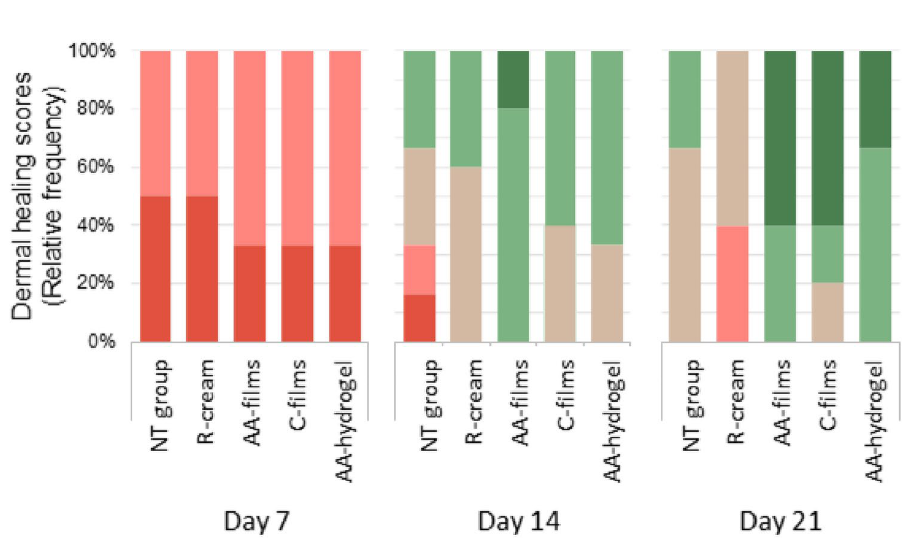
Figure 7. Dermis scores were recorded as relative frequency of cases/week as: ( 1) Complete dermal disorganization, ( 2) Reticular recovery, papillary disorganization, ( 3) Recovery of reticular and papillary dermis, ( 4) Normal reticular dermis with papillary recovery, ( 5) Completely normal